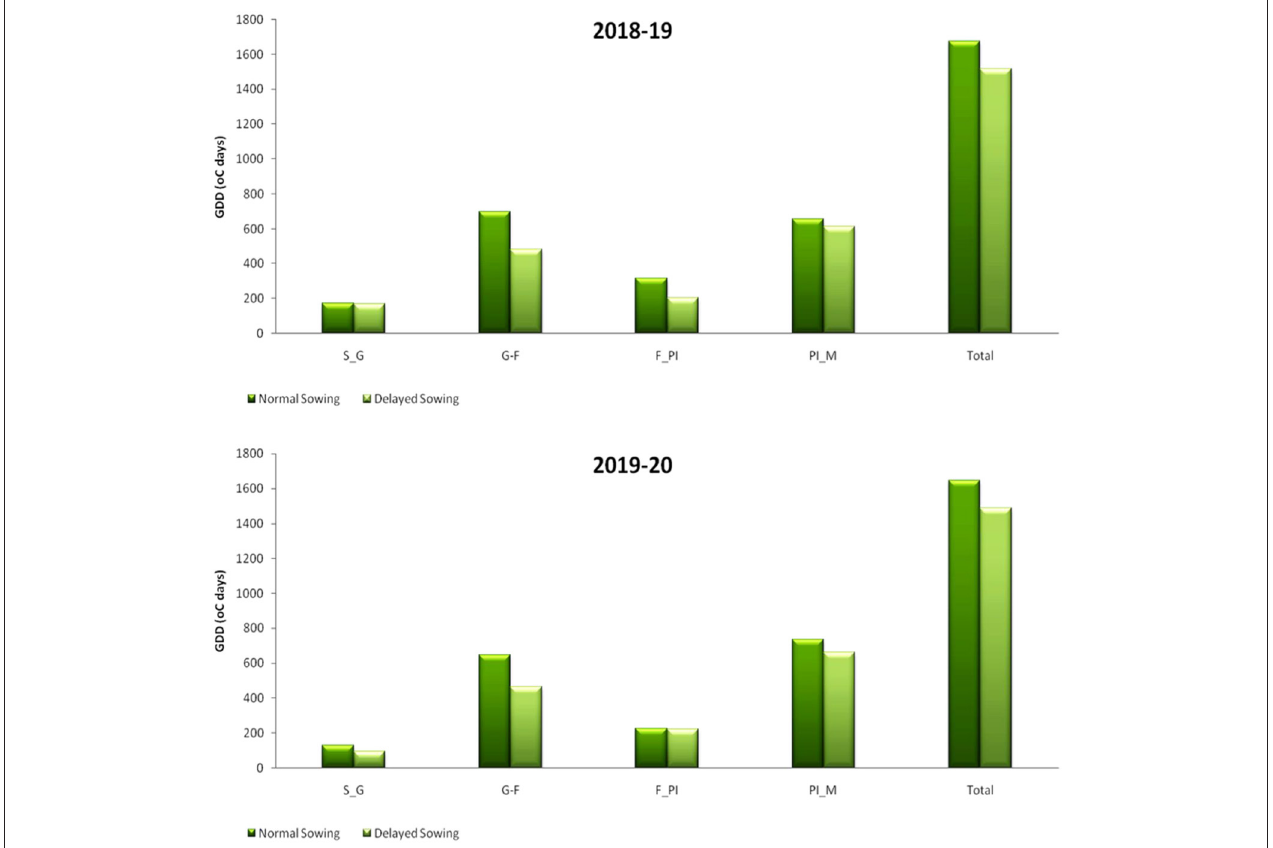
FIGURE 5 | GDD at different growth period under different dates of sowing (data of 2018–2019 and 2019–2020 crop seasons). S–E, sowing to emergence; G–F, germination to flower initiation; F–PI, flower initiation to pod initiation; and PI–M, pod initiation to maturity.